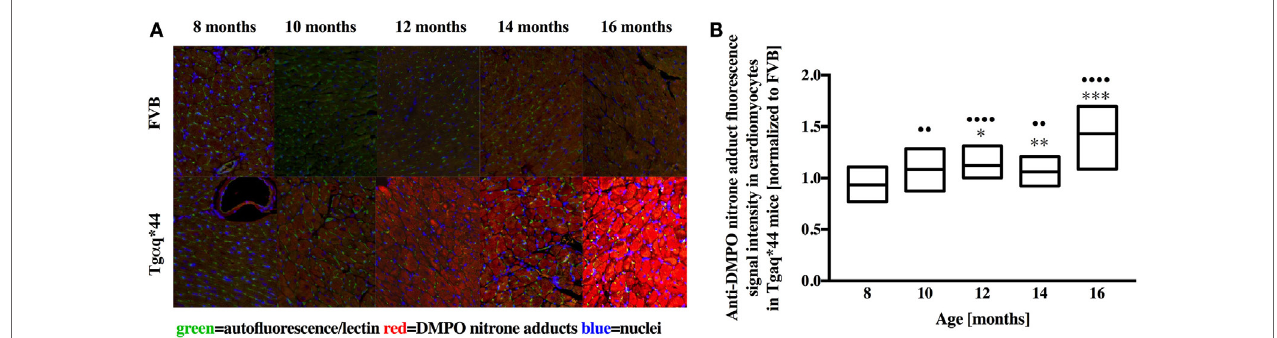
FigUre 2 | Immunohistochemical detection of DMPO nitrone adducts in the hearts of Tg α q*44 normalized to aged-matched FVB mice. (a) Representative images of the left ventricle from 8- to 16-month-old mice. (B) Quantification of oxidative modifications, based on the DMPO fluorescent signal, normalized to aged-matched FVB mice (see Section “Materials and Methods” for details). Results presented as median ± IQR. Statistical significance was assessed using the Kruskal–Wallis ANOVA, with post hoc Dunn’s test to compare oxidative modifications to 8-month-old group, with •• P < 0.01 and •••• P < 0.001. Statistical significance between Tg α q*44 and FVB mice in aged-matched groups was assessed using non-parametric, two-sided Mann–Whitney U test, * P < 0.05, ** P < 0.01, and *** P < 0.005. N = 4–6 mice per group, n = 10 slices per